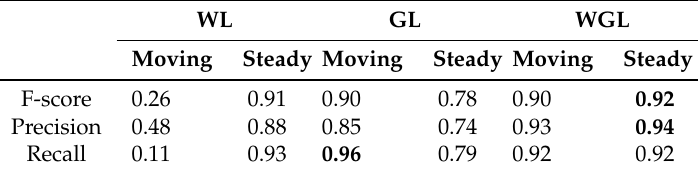
Table 3. Average accuracy of different sensor settings for each location